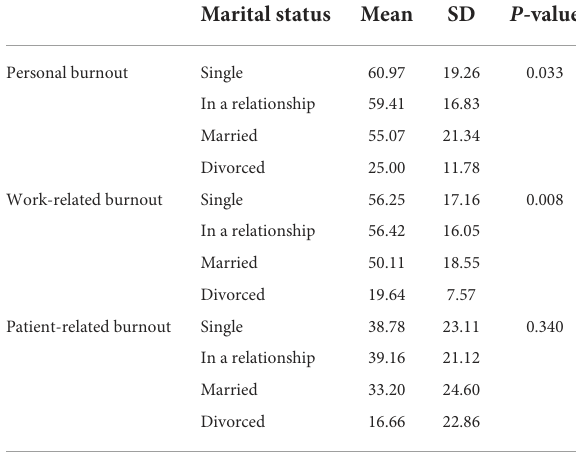
TABLE 4B One Way ANOVA Test between the mean of the three scales and year of